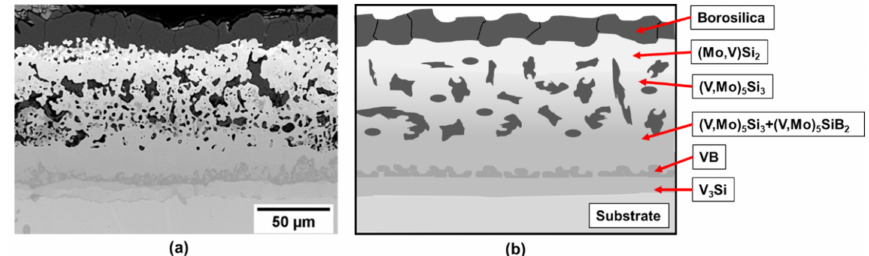
Figure 2. ( a ) Coating structure on pure vanadium substrate after exposure at 1100 ◦ C for 10 h and ( b ) schematic illustration of the coating structure.